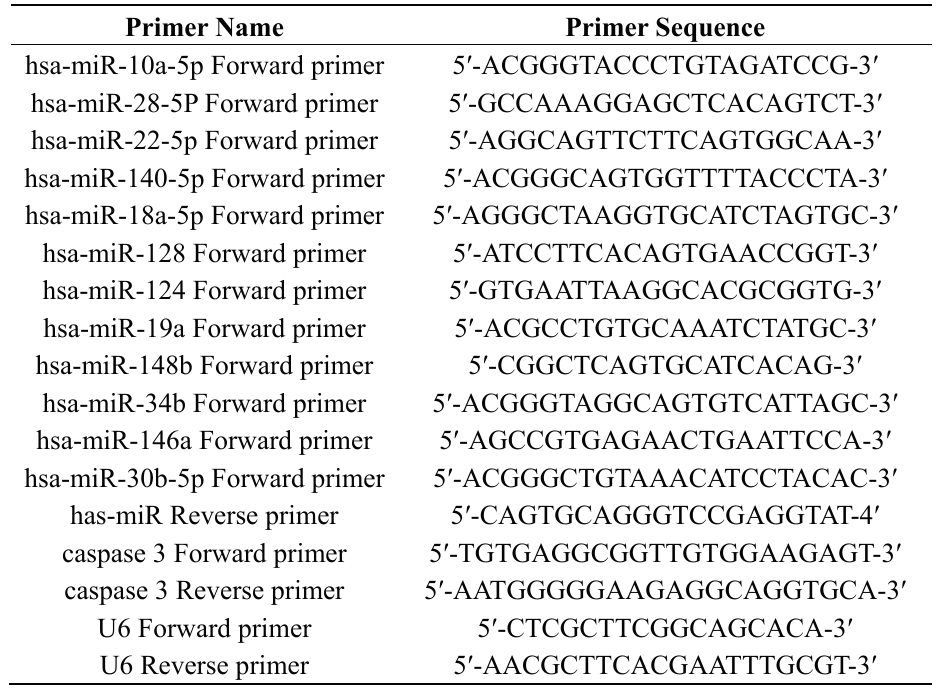
Table 4. Primer for real-time